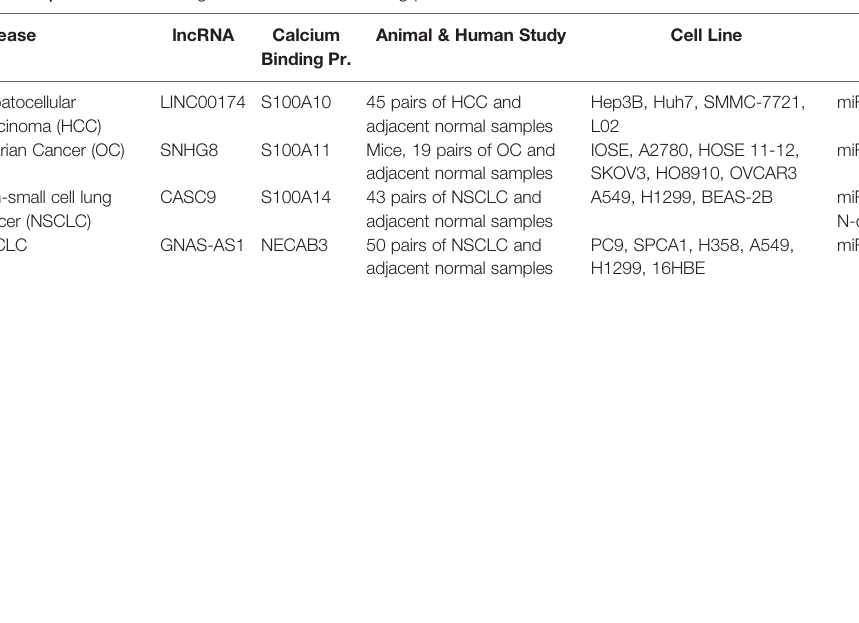
TABLE 9 | lncRNAs interacting with other calcium